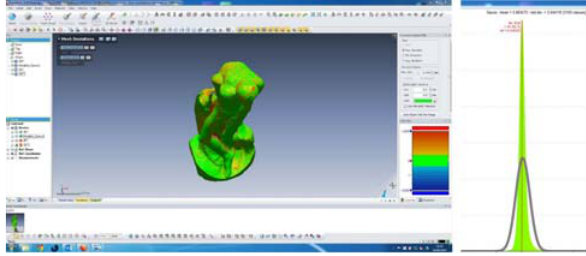
Figure 9. On the left: comparison between the scanner and the optimised photogrammetric model. On the right: the Gaussian distribution associated with the comparison.